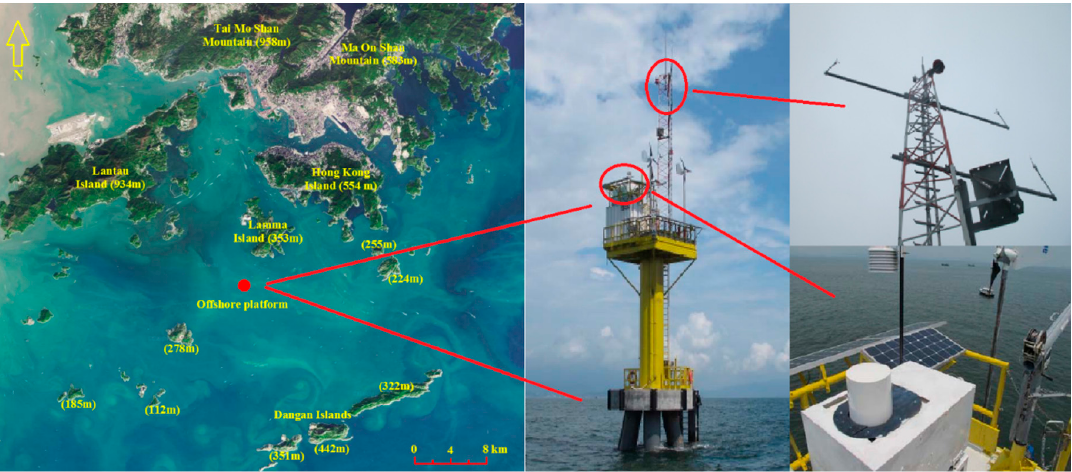
Figure 1. Location of measurement site (highlighted in solid red circle) and wind measurement system (upper: met mast; bottom: wind Lidar).